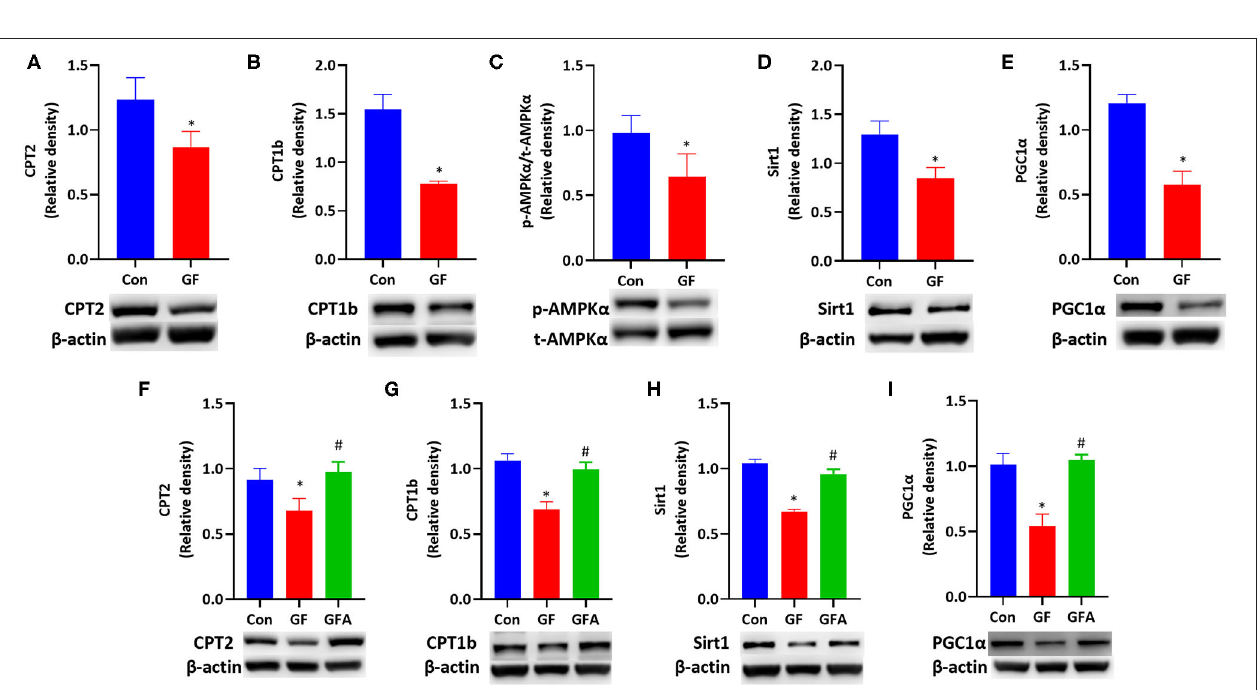
FIGURE 5 | Glucolipotoxicity reduced FAO-related protein expression by suppressing the AMPK signaling pathway and reversed by AICAR. (A–E) JEG-3 cells were treated with BSA (Con) or glucose/FFA (GF), which were treated for 10min for AMPK α and treated for 24h for other proteins. (A) CPT2; (B) CPT1b; (C) p-AMPK α /t-AMPK α protein ratio; (D) Sirt1; (E) PGC1 α . (F–I) JEG-3 cells were treated with BSA (Con) or glucose/FFA (GF) or glucose/FFA/AICAR (GFA) for 24h. (F) CPT2; (G) CPT1b; (H) Sirt1; (I) PGC1 α . The experiment was repeated three-five times. Data represented as the mean ± SEM. * p < 0.05, vs. Con. # p < 0.05, vs. GF. GF, glucose/FFA; GFA, glucolipotoxicity plus AICAR; AICAR, 5-aminoimidazole-4-carboxamide ribonucleotide; AMPK α , AMP-activated protein kinase α ; Sirt1, sirtuin 1; PGC1 α , peroxisome proliferator-activated receptor gamma coactivator 1-alpha; CPT1b, carnitine palmitoyltransferase 1b; CPT2, carnitine palmitoyltransferase 2.